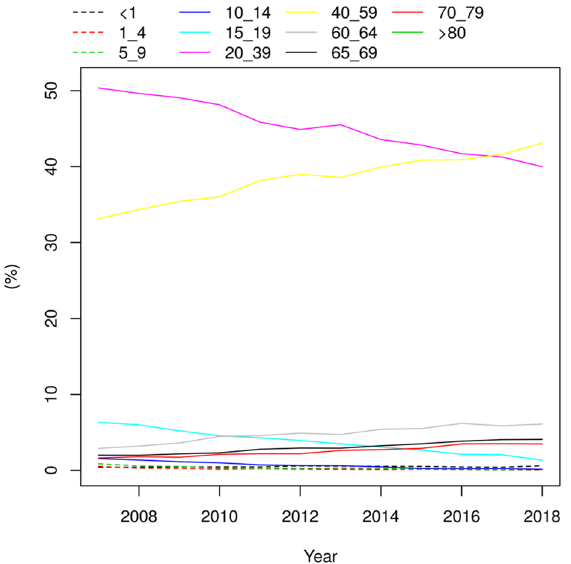
Figure 5. Hepatitis B infection trend according to age, distributed by year (from 2007 to 2018). The figure shows that individuals aged from 20 to 59 years old accounted for the higher number of HBV cases. as < 1; 1–4; 5–9; 10–14; 15–19; 20–39; 40–59; 60–64; 65–69; 70–79; > 80. This figure was created by using the R software 19 version 3.5.3 (https:// www.R- proje ct.